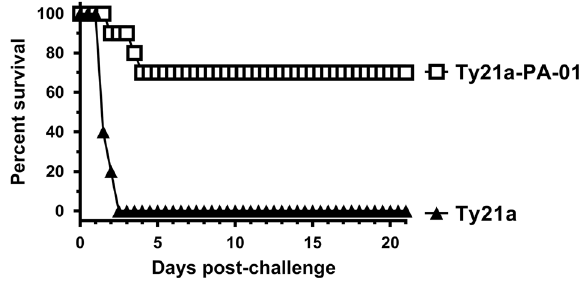
Fig. 4 Ty21a-PA-01 protects rabbits from a high dose lethal Ames spore challenge. Rabbits were immunized with 1 × 10 9 CFU of Ty21a control ( fi lled triangles ) or Ty21a-PA-01 ( open squares ) by the IP route four times at 4-week intervals. Two weeks after dose 4, rabbits were challenged with aerosolized Ames spores at a dose of 200 LD 50 and monitored twice daily for 21 days. Mean TTD was calculated. None of ten control rabbits immunized with Ty21a survived; however, 7/ 10 rabbits immunized with Ty21a-PA-01 survived ( p = 0.0031, Fisher ’ s exact test, two-tailed). All 10 control rabbits died in 1.8 ± 0.4 days, and the mean TTD for the 3 immunized rabbits that died was 3.2 ± 1 days ( p = 0.039by Mann – Whitney U test,